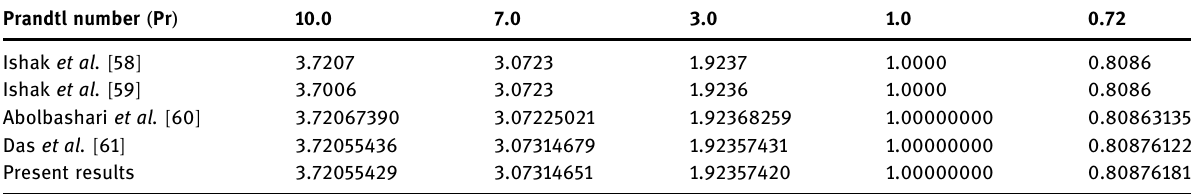
Table 3: Comparison of − θ ′ 0 ( ) by variation in Prandtl number, ϕ = 0, A = 0, Λ = 0, N r = 0, M = 0, Ec = 0, S = 0, and Bi ∞ ς → Prandtl number ( Pr )